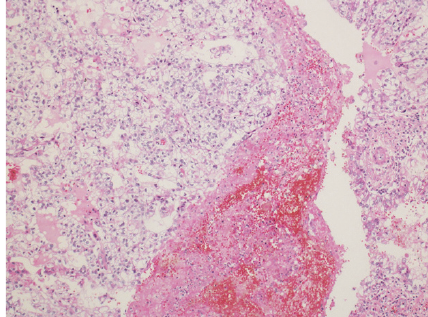
Figure 1: Axial CT scan showing heterogeneous 14 × 12 cm pelvic- abdominal mass between uterus and rectum, most likely originating from the left ovary and inseparable from the posterior uterus.